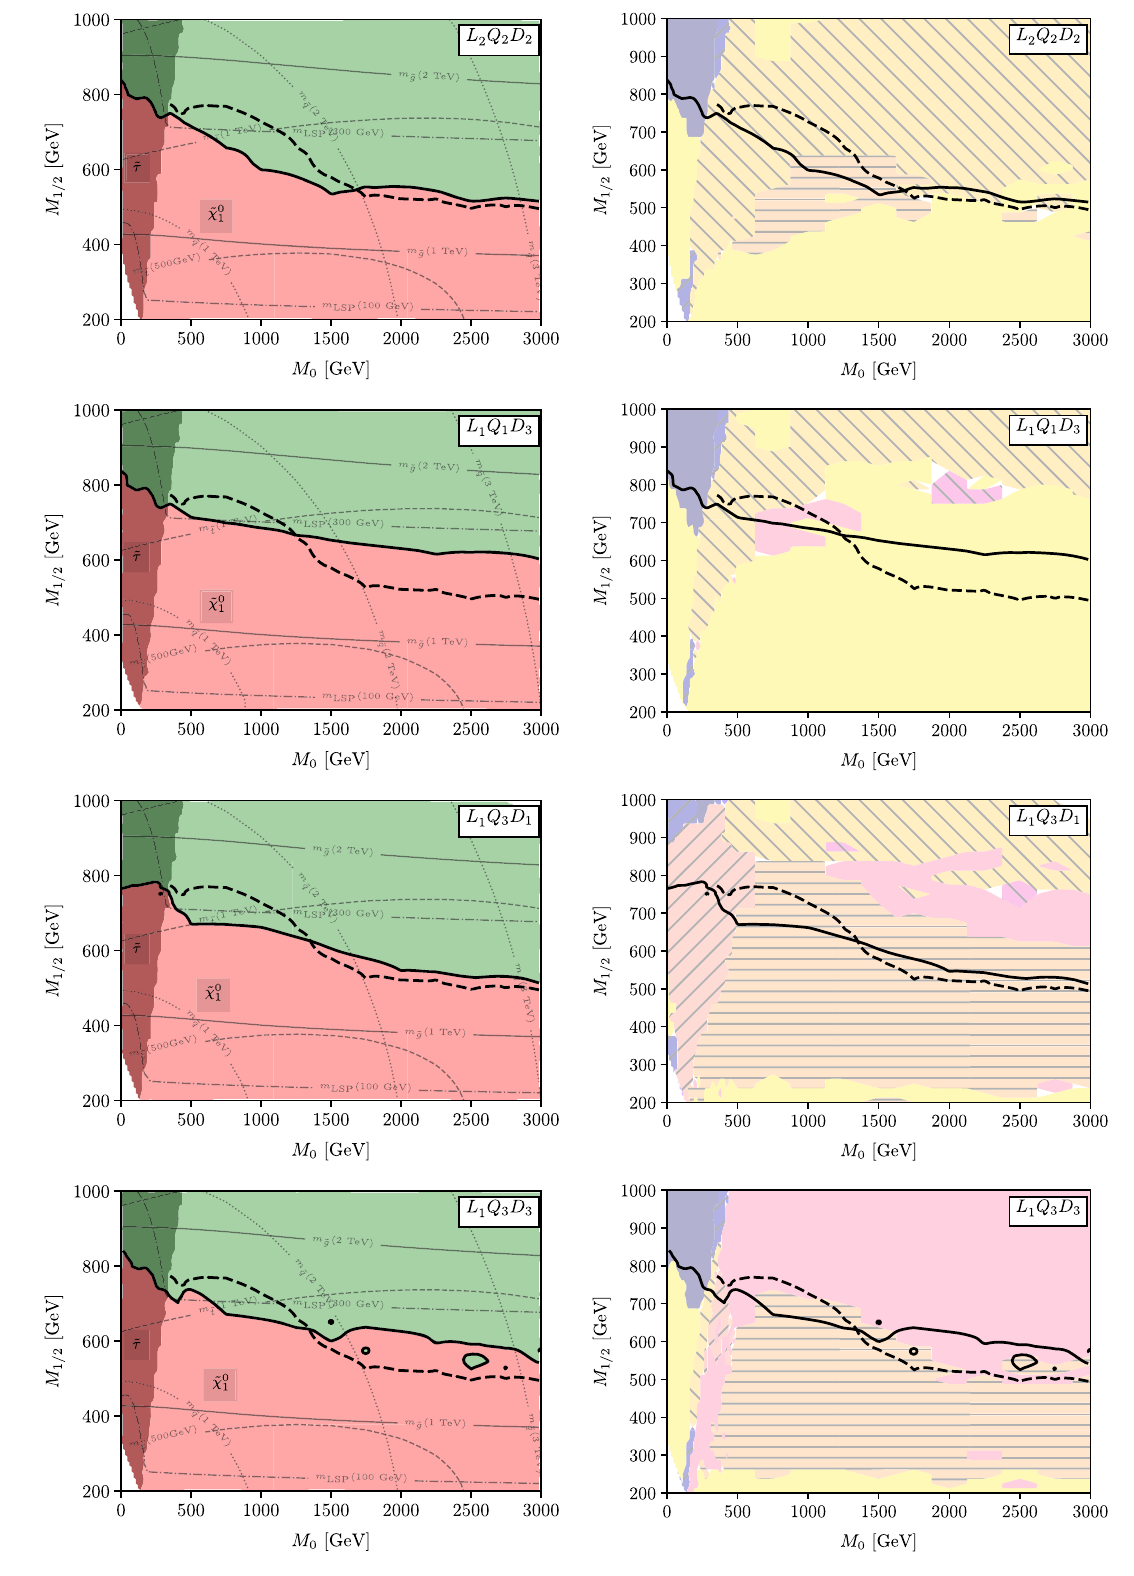
,λ (cid:4) ,λ (cid:4) and λ (cid:4) 222 113 131